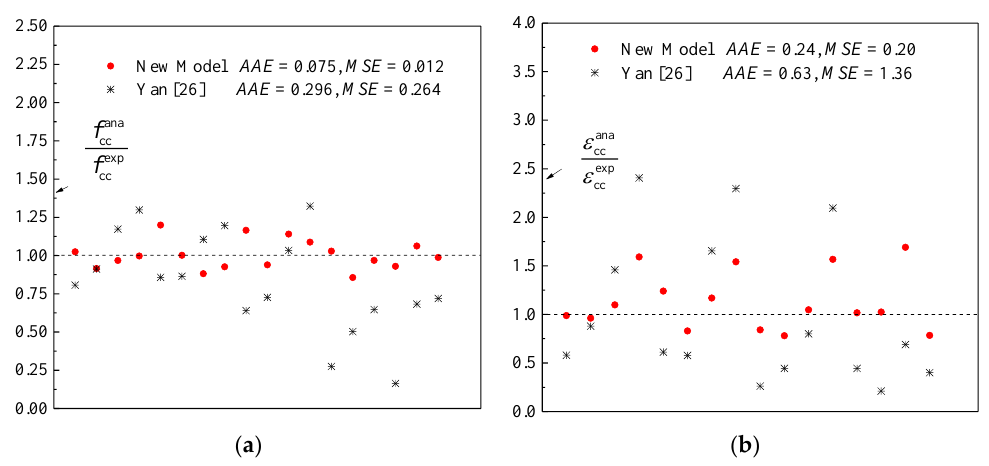
Figure 6. Comparisons of predictions made by the proposed and existing models with experimental test results: ( a ) confined peak strength (Equation (7)); ( b ) corresponding axial strain (Equation (8)).